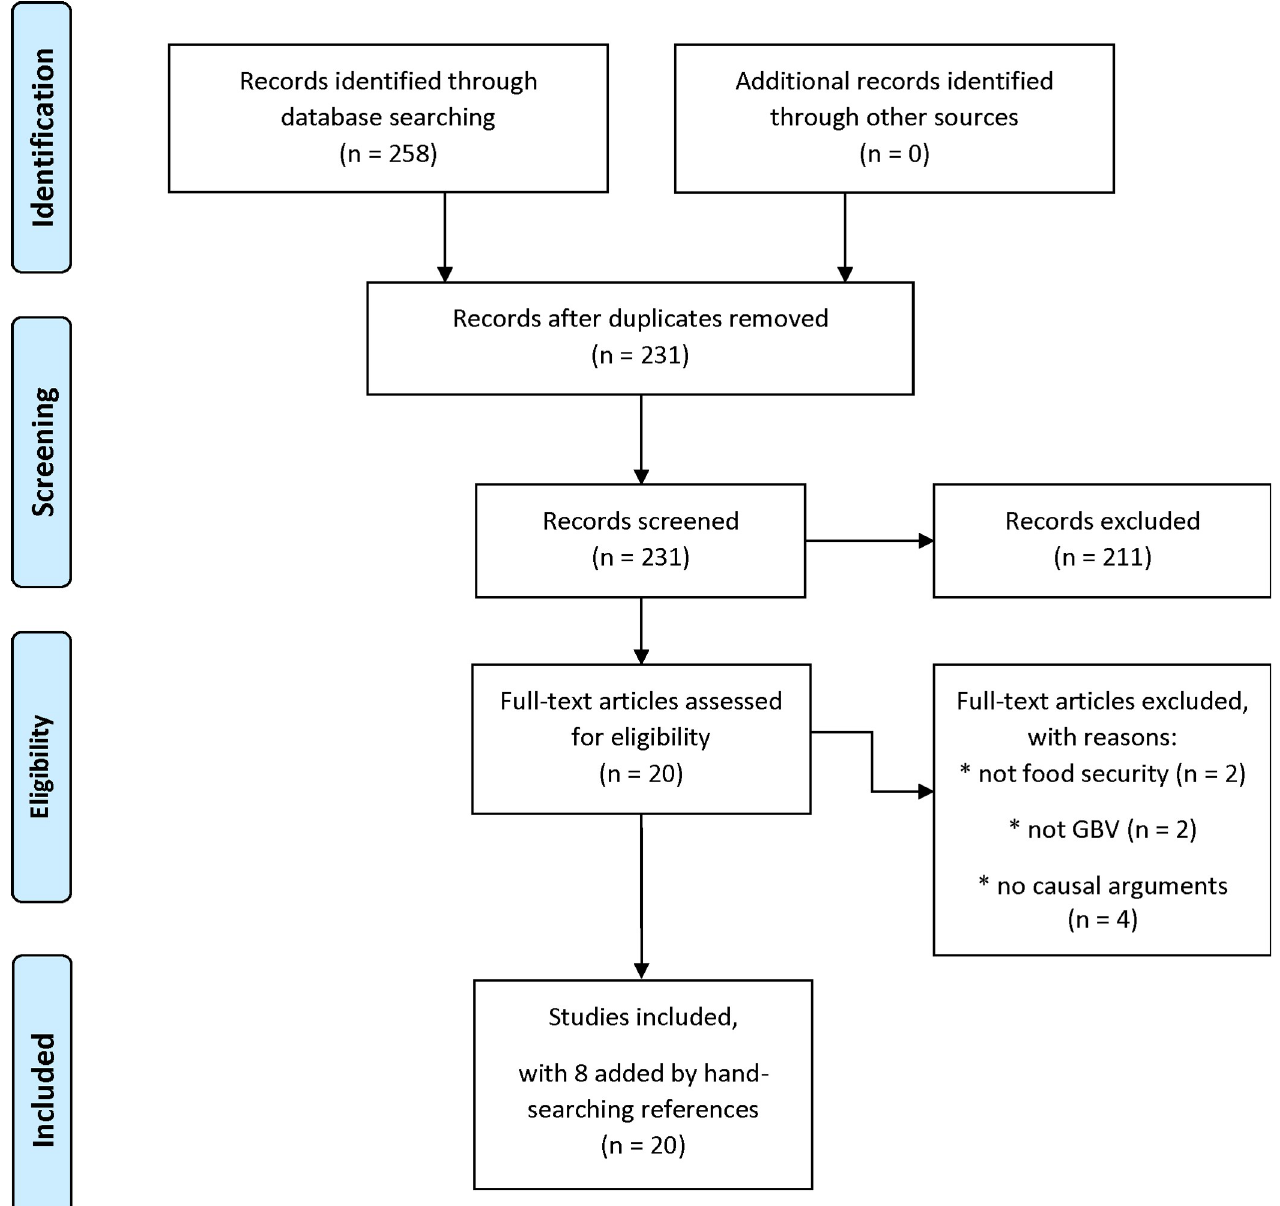
Fig 1. PRISMA flow diagram for scoping review investigating the interrelationship between food security, climate change, and gender-based violence (GBV).